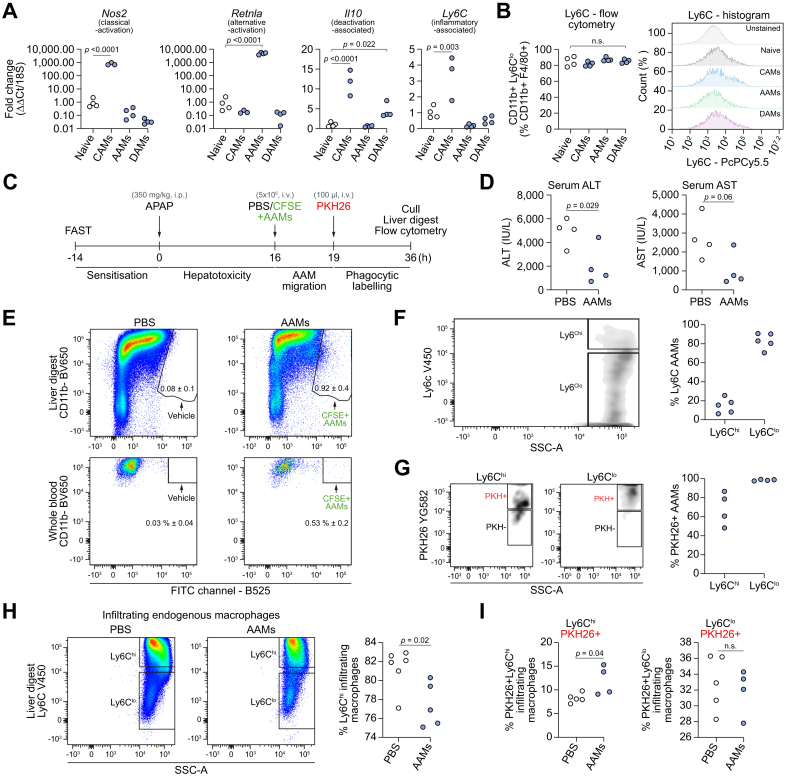
Injected AAMs are primarily Ly6Clo and highly phagocytic in situ.(A) Relative gene expression in BMDM populations (determined by 2−ΔΔCT method; standardised to naïve BMDMs, after 18S normalisation): Nos2 — CAM-associated gene, Retnla — AAM-associated gene, Il10 — DAM-associated gene, Ly6C — proinflammatory-associated gene (n = 3/4 biological replicates per group). (B) Ly6C status in BMDM populations (flow cytometry quantification, left panel; cytometry histograms, right panel) (C) Study design: CFSE-labelled AAMs injected (5 × 106, i.v.) at 16 h in APAP-ALI mice, 3 h before PKH26 (fluorescent phagocytic tracer). Cull at 36 h. (D) Serum ALT activity (left) and AST (right) in APAP-ALI mice treated with PBS or AAMs (n = 4 per group). (E) Gating shows CFSE+ AAMs in liver digests (top panels) and whole blood (bottom panels) in AAM-treated APAP-ALI mice. (F). Representative flow plot of Ly6C status in retrieved CFSE+ AAMs (gating: left panel; quantification: right panel, circles represent digests from individual mice). (G) Representative flow plots showing PKH uptake in Ly6Chi (left panel) and Ly6Clo (middle panel) AAMs, quantification in right panel. (H) Representative flow plots show Ly6C status in infiltrating endogenous macrophages in liver digests from APAP-ALI mice treated with PBS (left panel) or AAMs (middle panel), quantification in right panel. (I) Quantification of PKH uptake in Ly6Chi (left panel) and Ly6Clo (right panel) infiltrating endogenous macrophages. p values provided in panels, n.s. not significant. One-way ANOVA (A), unpaired t test (D, I), or Mann-Whitney U test (H) were performed. AAMs, alternatively activated macrophages; ALI, acute liver injury; ALT, alanine aminotransferase; APAP, acetaminophen; APAP-ALI, APAP-induced ALI; AST, aspartate aminotransferase; BM, bone marrow; BMDMs, bone marrow-derived macrophages; CAMs, classically activated macrophages; DAMs, deactivated macrophages.